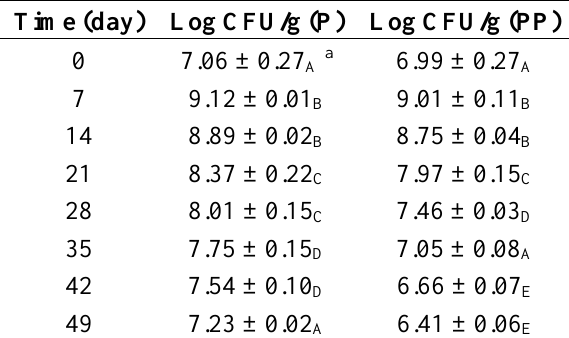
Table 1. The average of probiotic log counts ( n = 3) of oatmeal coconut water matrix during refrigeration storage (4